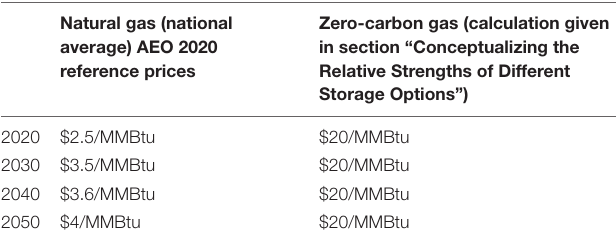
TABLE 3 | Fuel cost